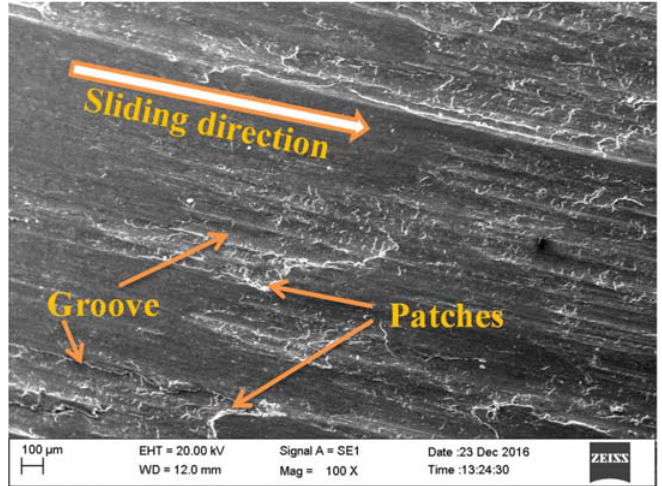
Figure 8: SEM image of the ice quenched (Al - 2 % of Al 2 O 3 - 2 % SiC) composites